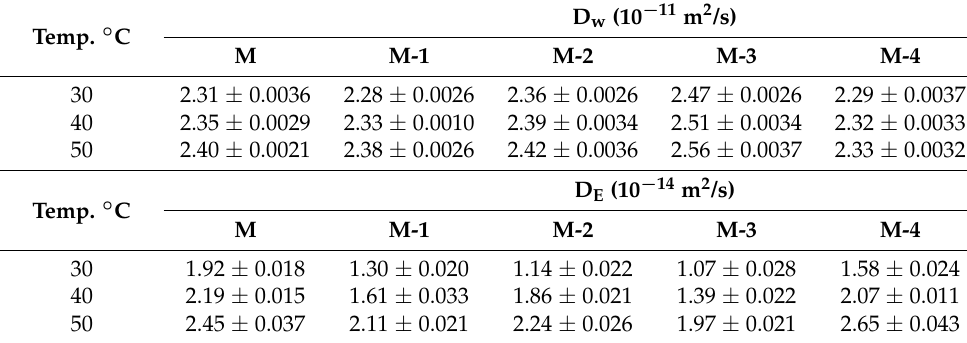
Table 5. The diffusion coefficients of water and bioethanol of all the membranes at different temperatures. Temp. ◦